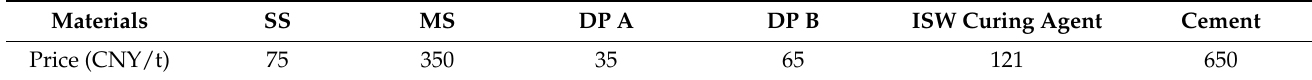
Table 6. Unit price of curing-agent raw materials.